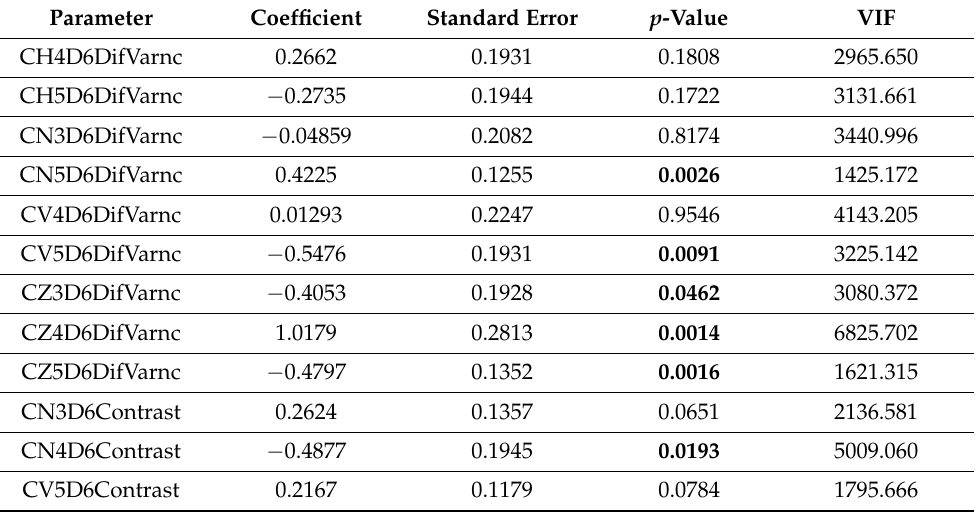
Table 5. Multivariate analysis results showing the texture parameters independently associated with the presence of